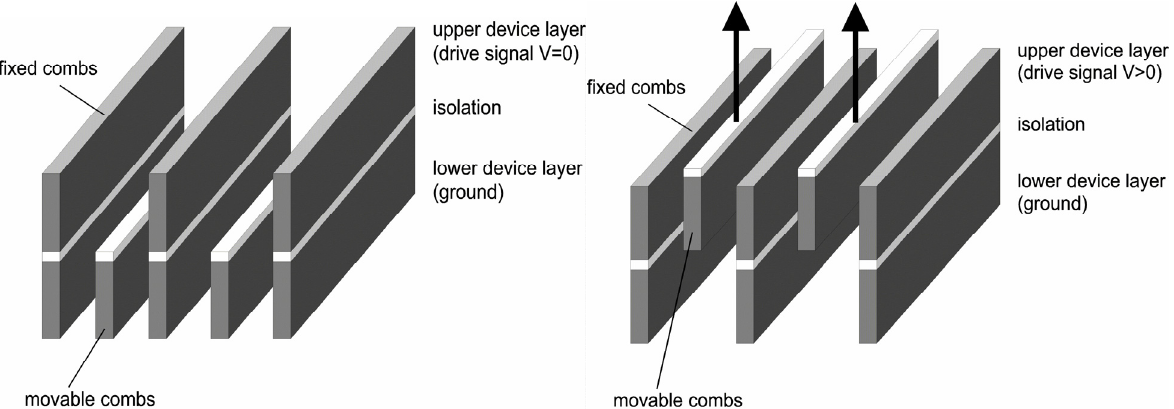
Figure 2. Electrostatic actuation by stacked vertical comb